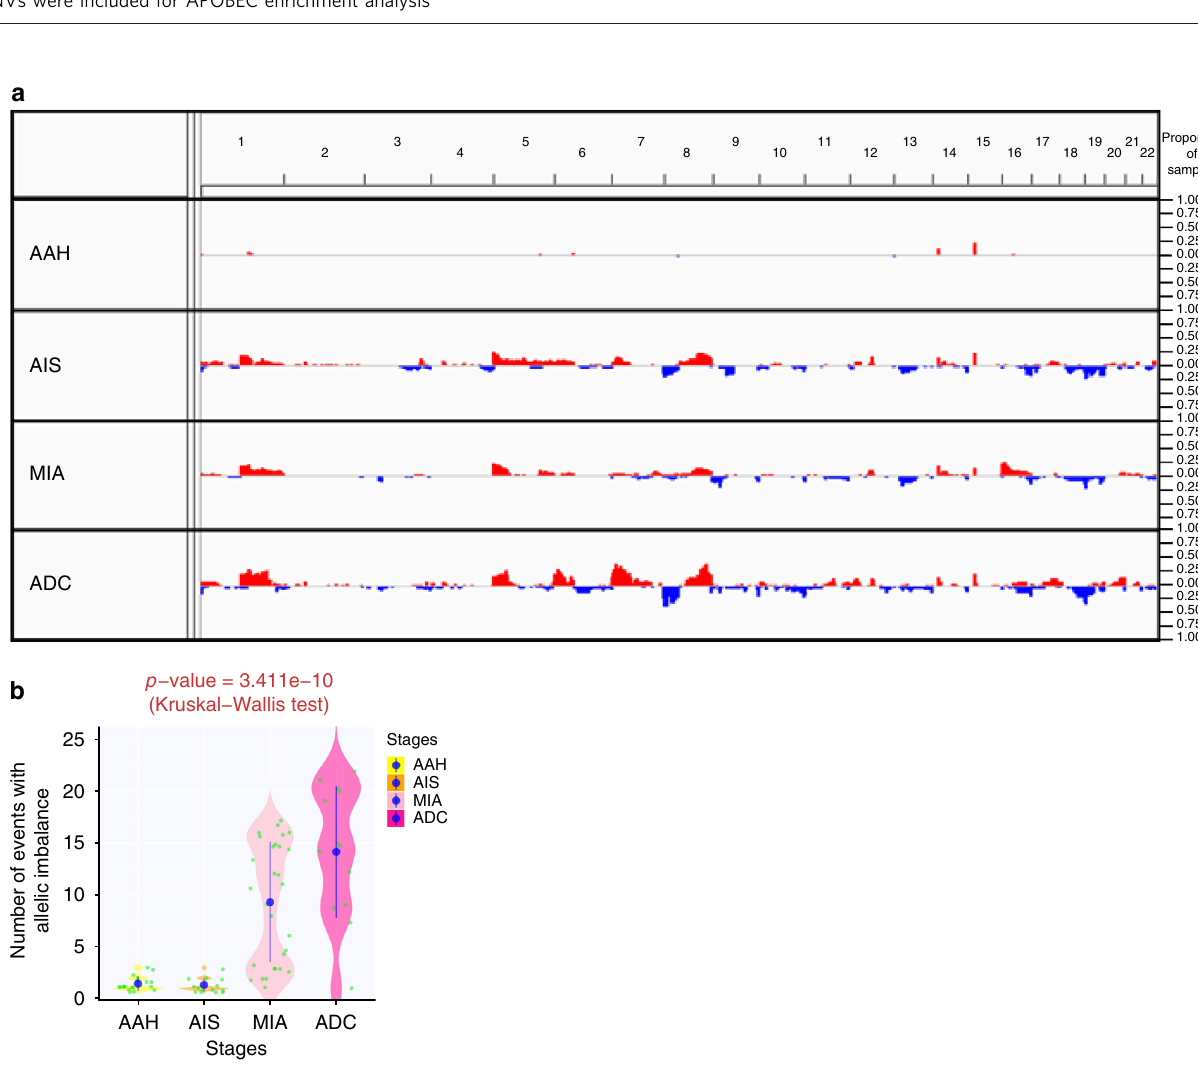
Fig. 1 Progressive genomic evolution from AAH to ADC at the single nucleotide level. a Mutational burden. Each dot represents the mutational burden in each IPN from smokers (green) or non-smokers (purple). The solid blue dots represent the mean mutational burden of all lesions of each histologic stage. Kruskal – Wallis H test was used to compare mutational burden among all stages. b Mutational burden in smokers versus non-smokers. The violin plots represent the distribution of mutational burden in smokers (green) and non-smokers (purple), respectively, by each stage. The circles represent the mean mutational burden of IPNs from smokers (green) or non-smokers (purple) by each stage. Wilcoxon Rank-Sum test was used for the comparison between smokers and non-smokers. c Top 10 enriched mutational signatures. The Alexandrov-COSMIC mutational signatures were derived from all mutations in each IPN. Only IPNs with a minimum of 100 unique SNVs were included in mutational signature deconstruction. The stacked bar plot represents the fraction of estimated mutations for each signature in each IPN. d The enrichment of APOBEC-mediated processes. Each green dot represents APOBEC enrichment score in each IPN and the solid blue dots represent the mean APOBEC enrichment scores of all IPNs of each histologic stage with 95% con fi dence interval as error bars. The statistical signi fi cance between all stages was assessed by Kruskal – Wallis H test. Only lesions with a minimum of 10 SNVs were included for APOBEC enrichment analysis